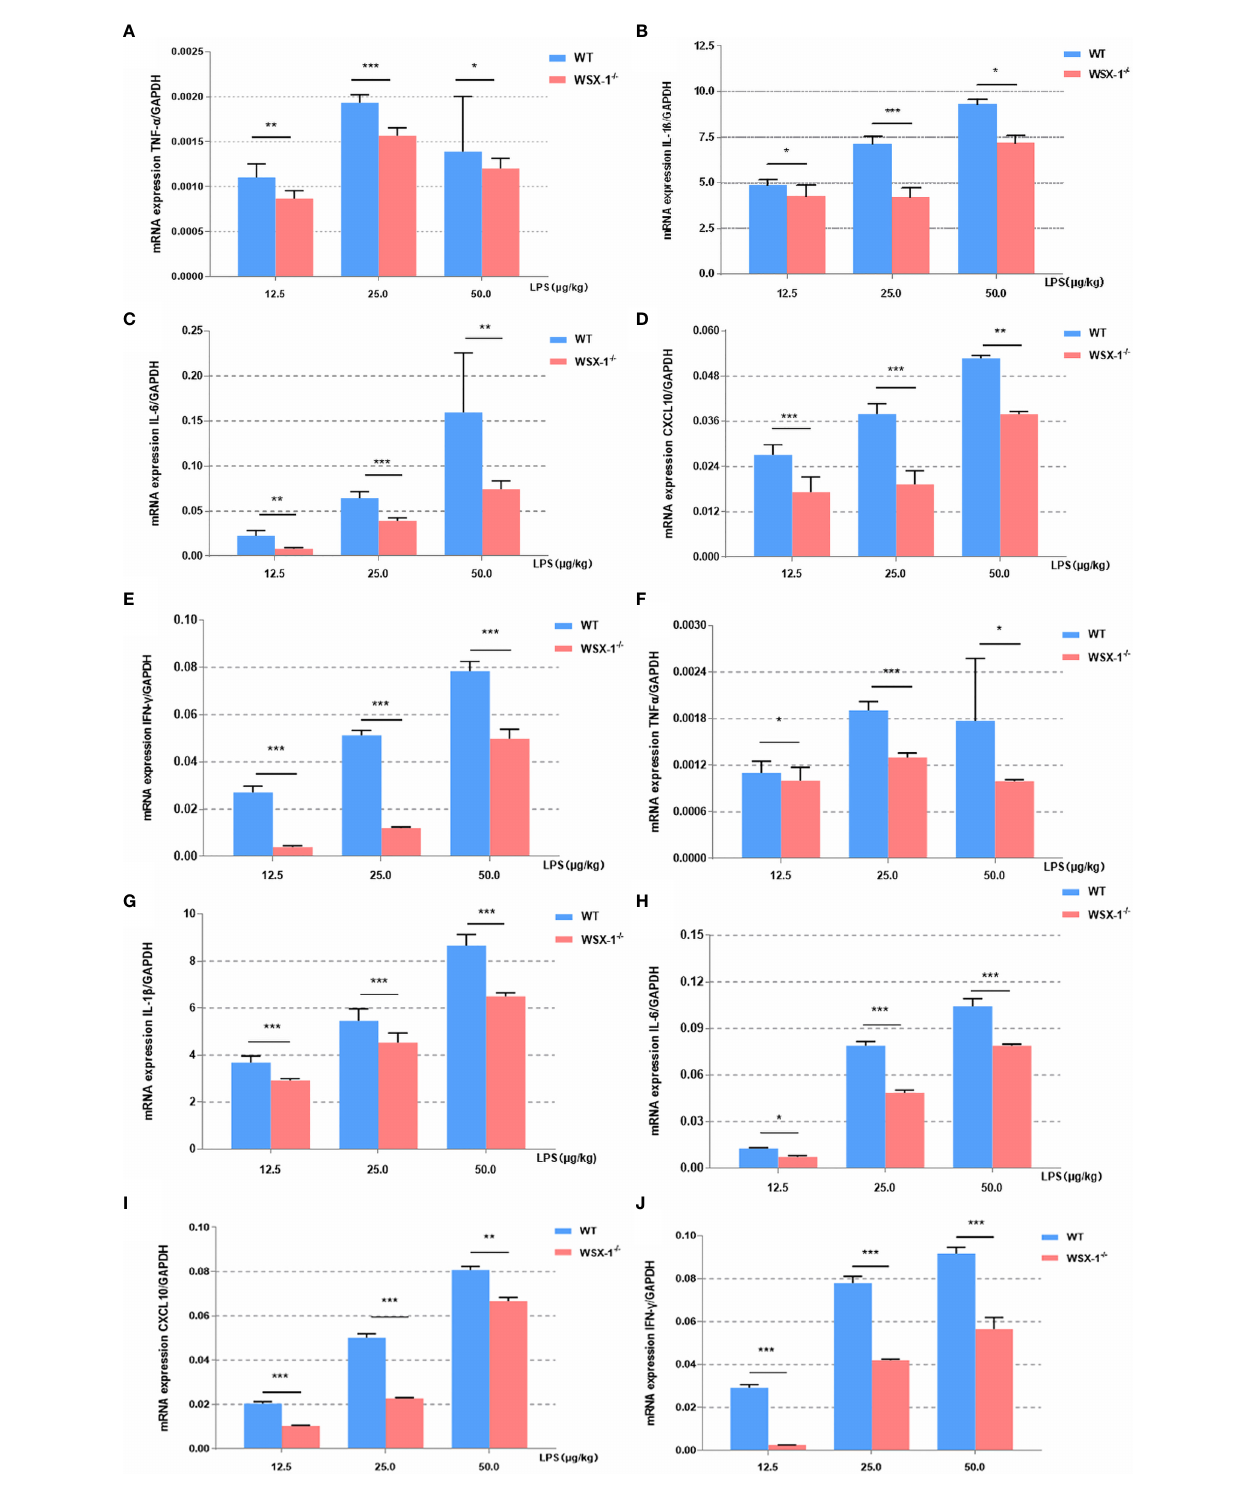
FIGURE 3 | In fl ammatory effects induced by LPS at the maternal-fetal interface from both genotypes. Concentration-dependent effects of LPS (12.5 µg/kg, 25 µg/kg, and 50 µg/kg) for 6 h on the mRNA expression of a range of key cytokines, including TNF- a , IL1 b , IL6, IFN- g , and CXCL10, in the fetal membranes (A – E) and uteri (F – J) of WT or WSX -/- mice. Data are expressed as the mean ± SEM and the Student ’ s t-test. *P < 0.05, **P < 0.01 and ***P < 0.001 when compared between groups denoted by horizontal lines (n =